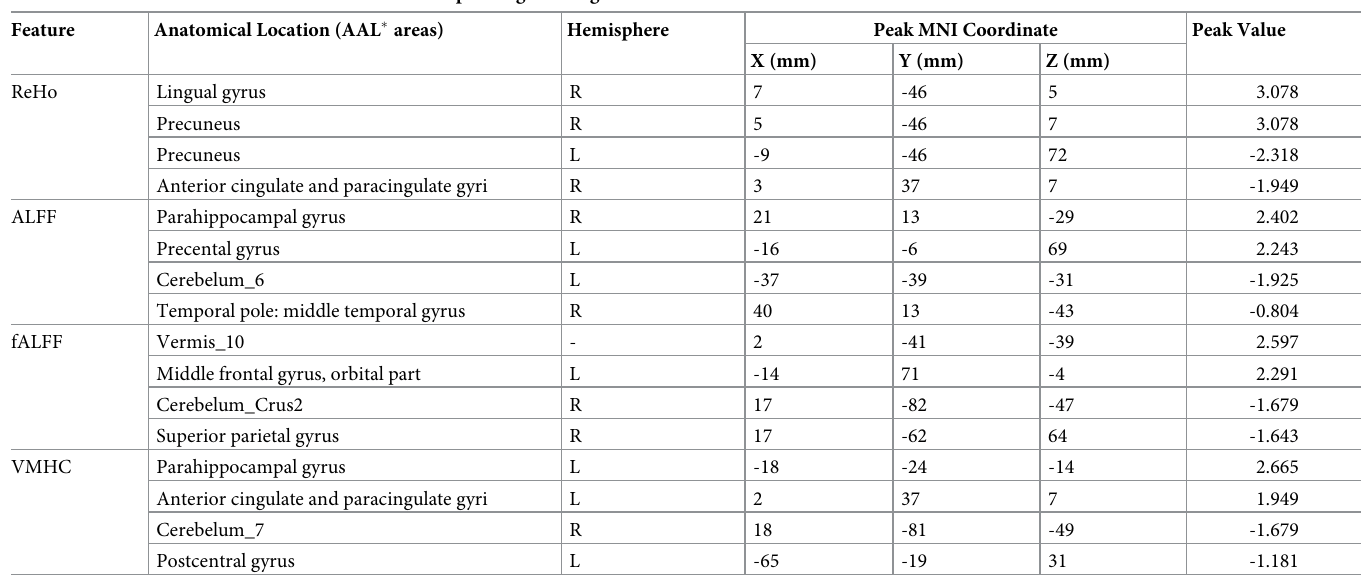
Table 7. The most discriminative measures and corresponding AAL regions. Feature